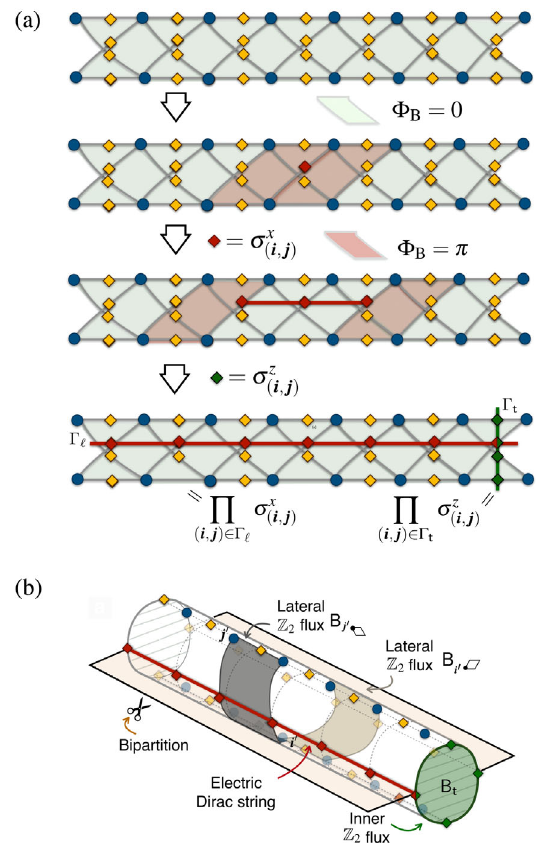
FIG. 5. Ground-state degeneracy of the Creutz-Ising cylinder. (a) In the h=J → 0 limit, the ground-state corresponds to the zero- flux state (green plaquettes), and excitations correspond to π -flux plaquettes (red) connected by an electric-field string (red line). By extending the string to the ladder edges, one recovers a different zero-flux ground state. (b) By considering the crossed-link tunnelings of the ladder as two different paths enclosing an area, the Creutz ladder can be represented as a thin-cylinder limit of a 2D